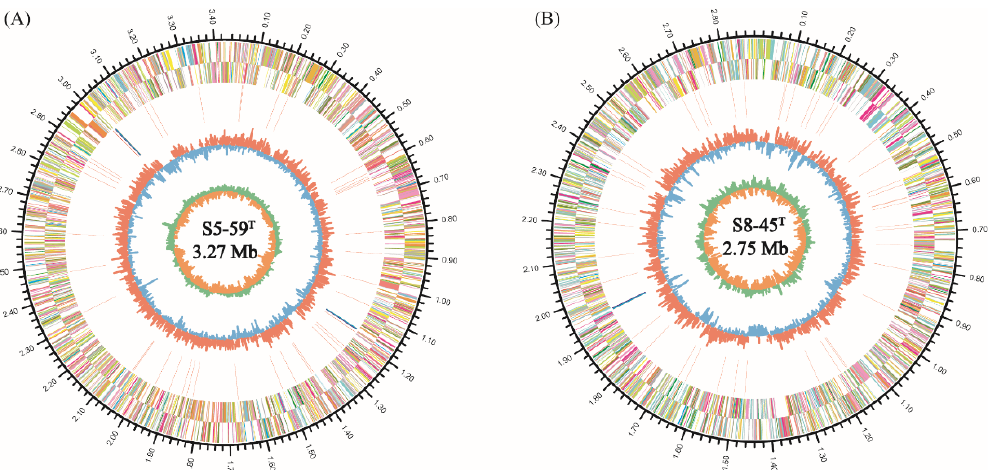
Figure 5. Circular chromosome map and COG functional categories of the strains S5-59 T ( A ) and S8-45 T ( B ) genomes. The circles show the different descriptions of the content in metabasins, from the outside to inward: the outer circle represents the genome size, the second circle and the third circle represents the predicted protein-coding sequences and CDS regions on the plus and minus strands, respectively. The colors represent COG functional classification. The fourth circle represents the repeated sequence. The fifth circle represents tRNA and rRNA. The sixth circle shows GC content and the seventh circle exhibits the percent of GC-skew. (The detailed clusters of orthologous group information are shown in Table S3).